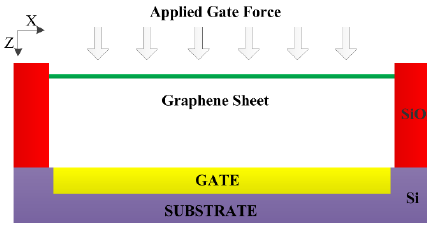
Figure 2. Model schematic of a graphene resonator.